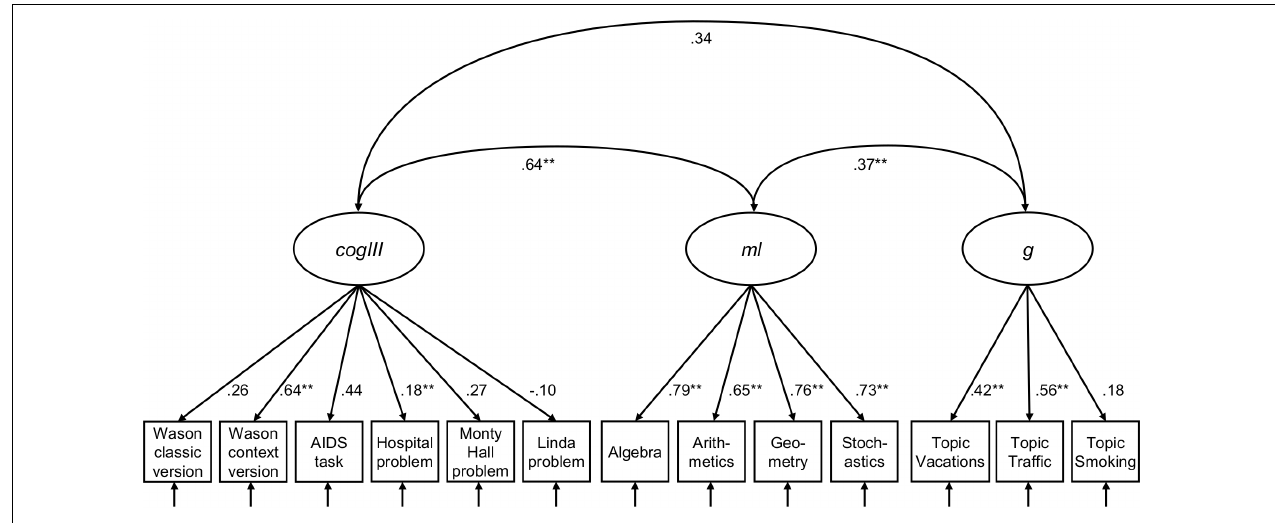
FIGURE 5 | Three-factor measurement model of cogIll , ml , and g. Model fit: N = 2,508, T [ χ 2 ] = 103.796, df = 51, p = 0.001, CFI = 0.990, TLI = 0.987, RMSEA = 0.017, SRMR = 0.084. The values display latent correlation or standardized coefficients, respectively. Values of χ 2 ≤ 3 df ( df = degrees of freedom), p ≥ 0.01, CFI (Comparative Fit Index) ≥ 0.95, TLI (Tucker-Lewis Index) ≥ 0.95, RMSEA (Root-Mean-Square Error of Approximation) ≤ 0.05, and SRMR (Standardized Root Mean Residual) ≤ 0.05 indicate a good model fit. cogIll : cognitive illusions, ml : mathematical literacy, g : general intelligence. *indicates p < 0.05; **indicates p <